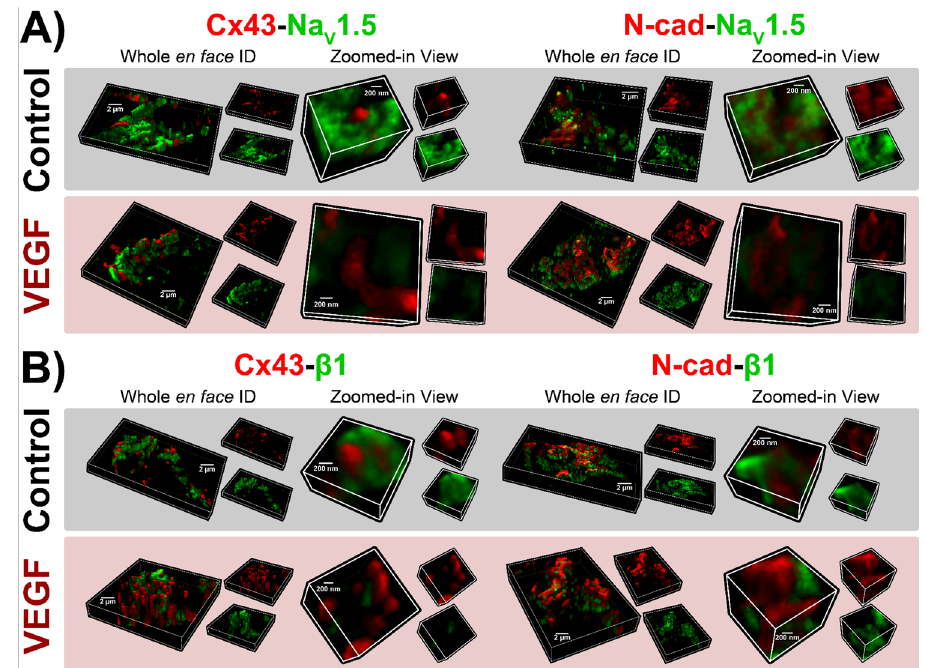
Figure 5. STED imaging of atrial IDs. Representative 3D STED images of en face IDs from VEGF-treated and control murine atria immunolabeled for ( A ) Na V 1.5 and ( B ) β1 along with Cx43 and N-cad.